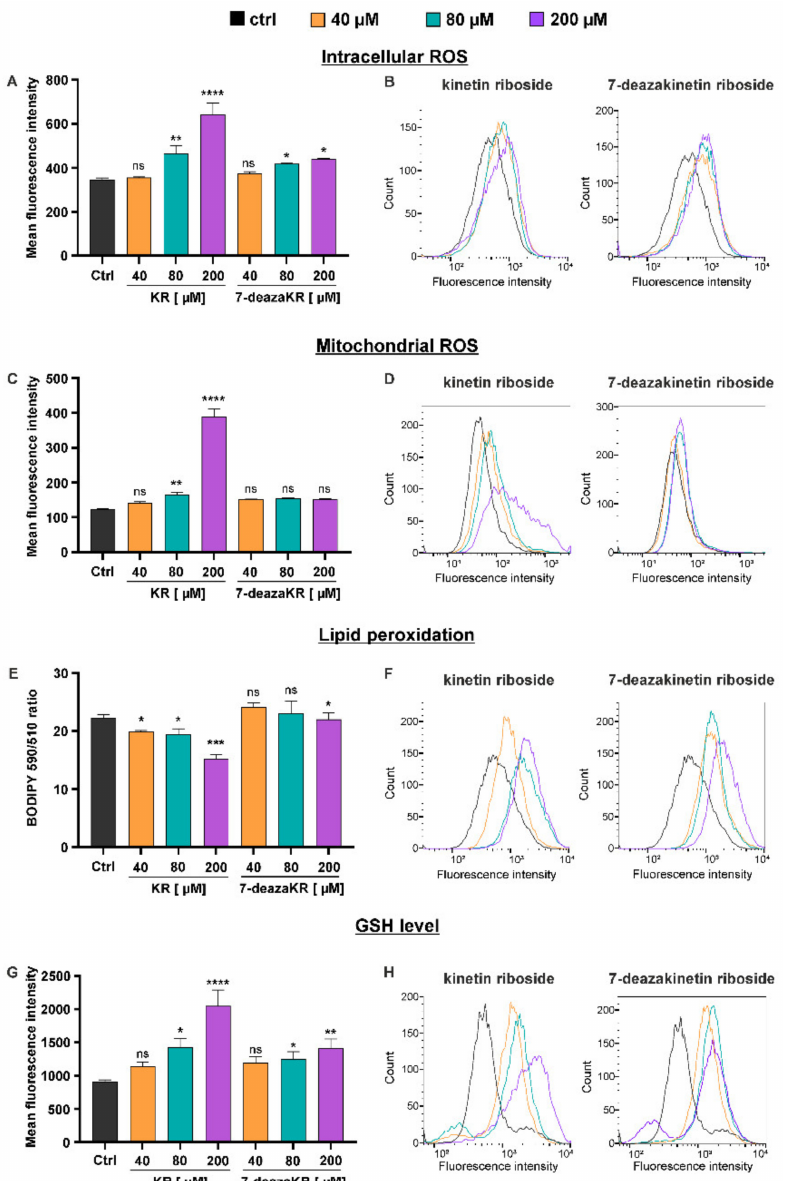
Figure 7. Influence of kinetin riboside and 7-deazakinetin riboside on oxidative stress parameters in T98G cells. ( A , B ) Intracellular ROS detection in the cells after KR and 7-deazaKR treatment (40–200 µ M). ROS production was examined by flow cytometry using H 2 DCFDA staining, and the fluorescence intensity was estimated. Data are shown as a bar graph of three independent experiments (mean ± SD, A) or as representative histograms ( B ). ( C , D ) Flow cytometry analysis of mitochondrial OS induction in T98G cells after KR and 7-deazaKR treatment (40–200 µ M) by using the MitoSOX fluorescent indicator. Fluorescence intensity shift was plotted in a bar graph (mean ± SD; C) and is presented as a representative histogram of three independent experiments ( D ). ( E , F ) Induction of lipid peroxidation in T98G cells after KR and 7-deazaKR treatment (40–200 µ M) analyzed by flow cytometry. Upon oxidation, the emission fluorescence of the BODIPY 581/591 probe shifts from 590 to 510 nm; the 590/510 ratio of fluorescence intensity is presented as a bar graph (mean ± SD) from three individual experiments ( E ). Fluorescence shift is also shown as representative histograms ( F ). ( G , H ) A simultaneous analysis of cellular GSH content measured by staining with the nonfluorescent Thiolite™ Green dye. The fluorescence intensity changes are given in a bar graph of three independent experiments (mean ± SD; ( G ) or presented as representative histograms ( H ). Statistical significance is indicated with asterisks: (ns) p > 0.05, * p < 0.05, ** p < 0.01, *** p < 0.001, **** p <